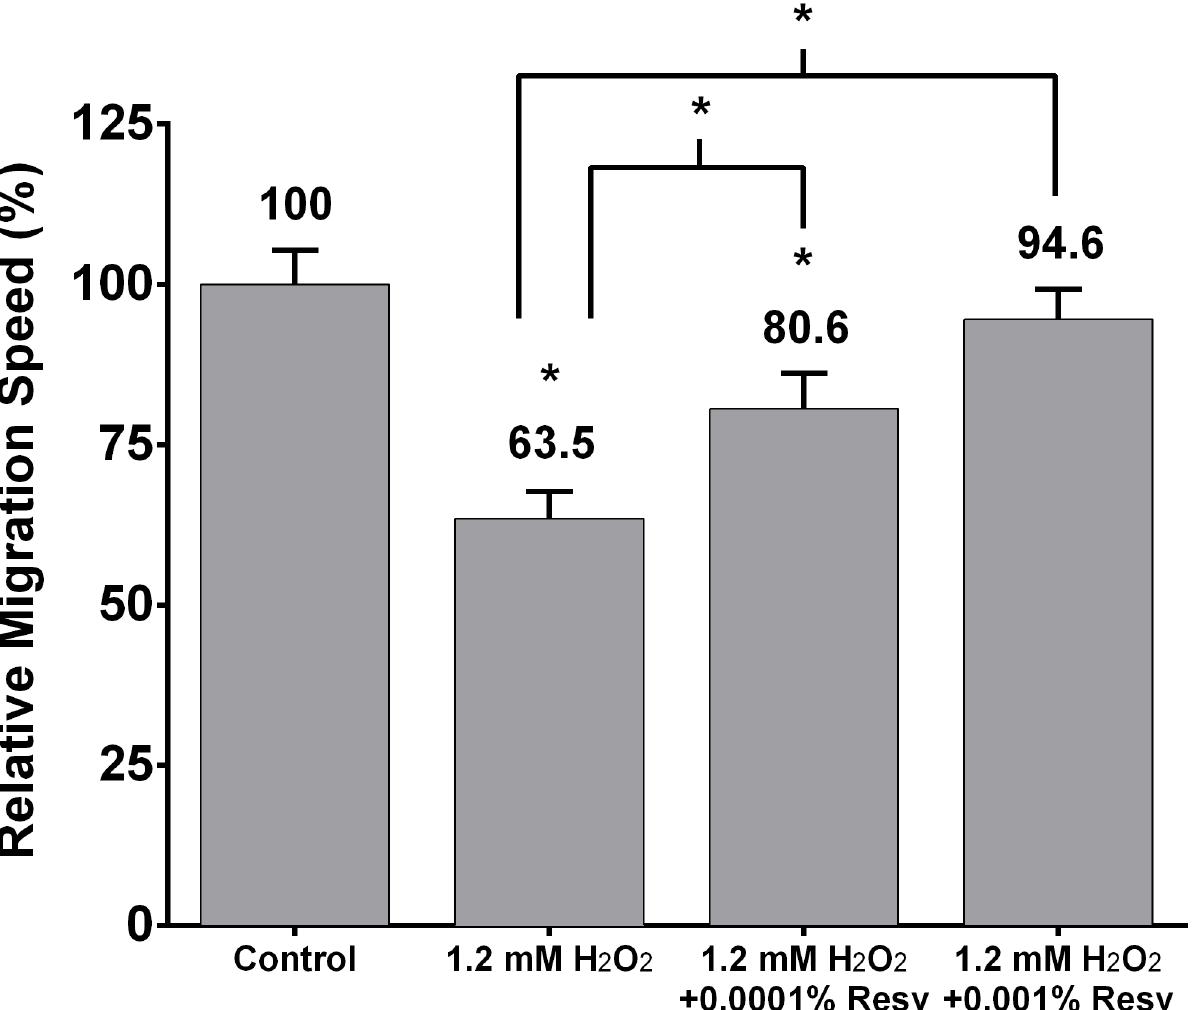
Fig 2. Pretreatment of fibroblasts with 1.2 mM H 2 O 2 for 30 minutes significantly decreased relative fibroblast migration speed to 63.5 ± 4.2% (p = 4.28 – 07) compared to matched controls (100 ± 5.3%). Pretreatment with 0.0001% resveratrol significantly prevented the effects of H 2 O 2 (1.2 mM) compared to LED-RL alone and resulted in a relative migration speed of 80.6 ± 5.5% (p = 0.024). Pretreatment with 0.001% resveratrol significantly prevented the effects of H 2 O 2 (1.2 mM) compared to LED-RL alone and resulted in a relative migration speed of 94.5 ± 4.7% (p = 0.001). Error bars represent standard error of the mean. ( * represents P <